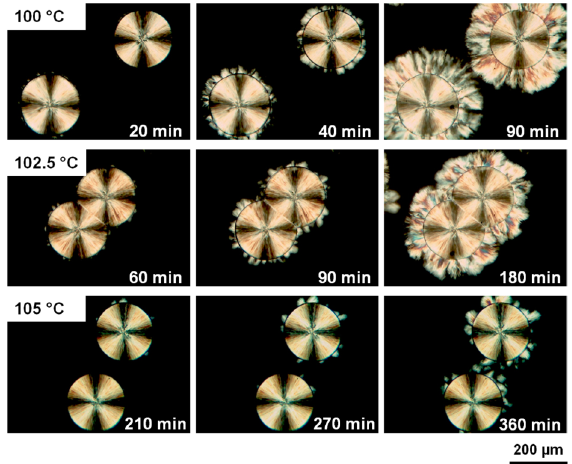
Figure 8. Optical micrographs taken during the form I induced form II crystallization of iPBu at different temperatures and for times as indicated in the pictures. Reproduced with permission from Ref. [62], copyright 2014 American Chemical Society.